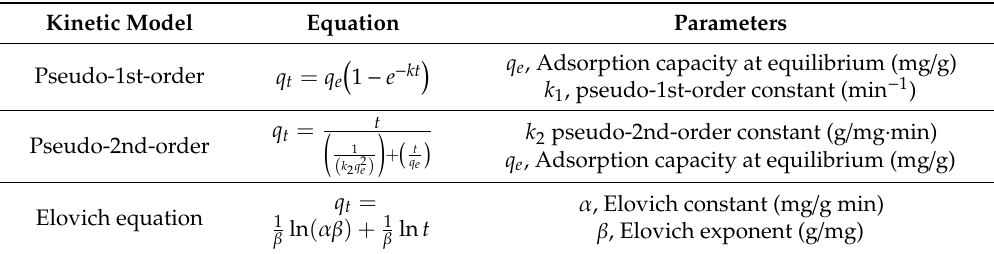
Table 1. Mathematical expressions of kinetic